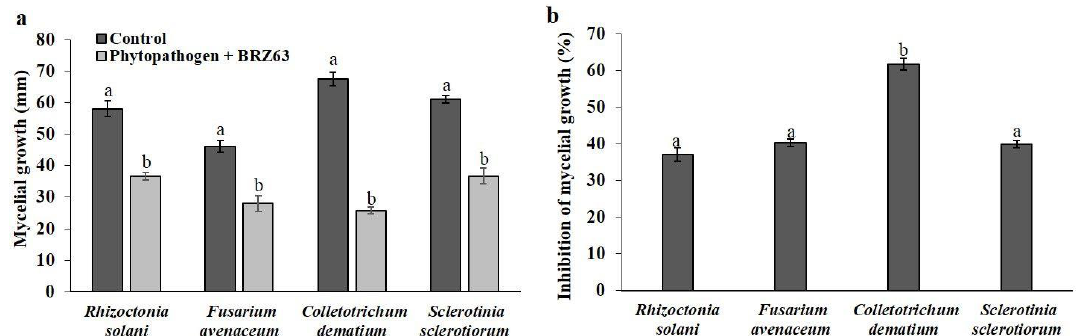
Figure 1. Effect of P. fluorescens BRZ63 on mycelial growth ( a ) and percentage (%) of inhibition of fungal phytopathogens’ mycelial growth by the BRZ63 strain ( b ). Each column represents the mean ± standard deviation of three independent replications for each treatment. a,b−indicate significant differences ( p < 0.05) according to the honest significant difference (HSD) test.